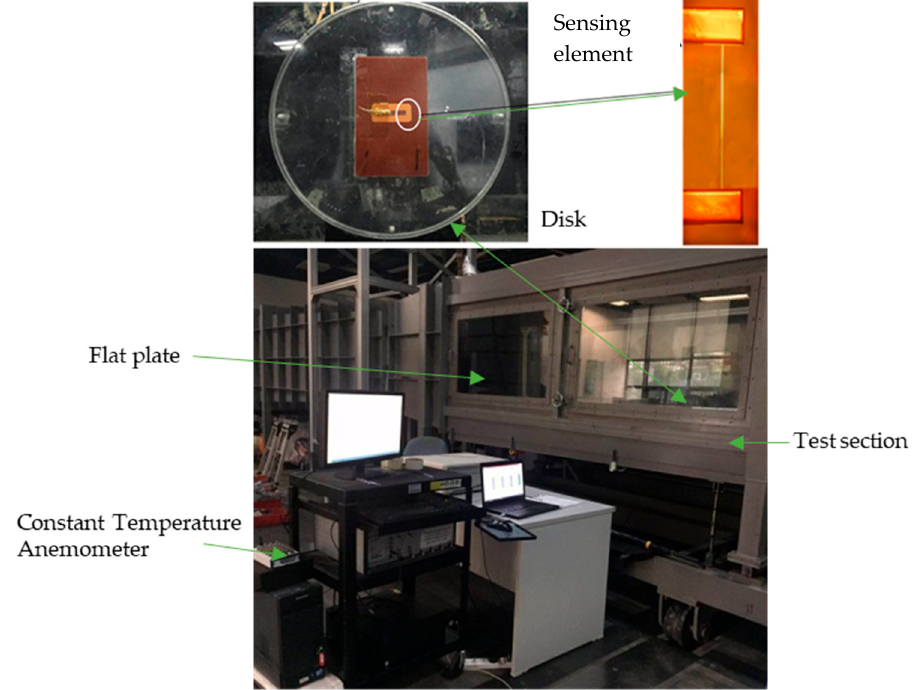
Figure 4. Wind tunnel setup: test section (5.6 m × 0.8 m × 1.0 m); flat plate (4.8 m × 0.78 m × 0.015 m).